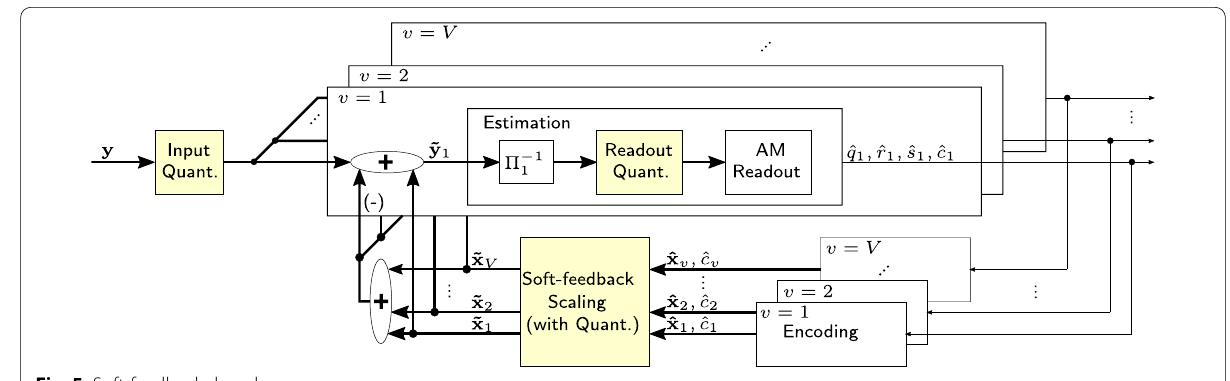
Fig. 5 Soft-feedback